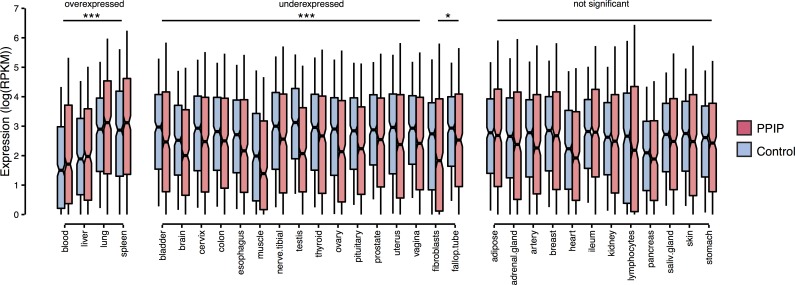
Tissue expression of PPIPs and control genes.The GTEx median RPKM + 1 values for each gene and tissue were log2 transformed and plotted for PPIPs (pink) and one set of control genes (blue), matched for total expression. Whiskers denote the range of values 0.1 times the interquartile range from the box. Significance was determined by permutation within each tissue, i.e., by comparing the mean expression of PPIPs to the means of 1000 sets of matched control genes. *** = p<0.001; * = p<0.05.